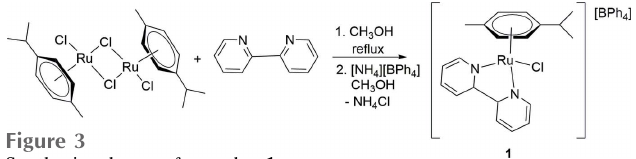
Figure 3 Synthesis scheme of complex 1